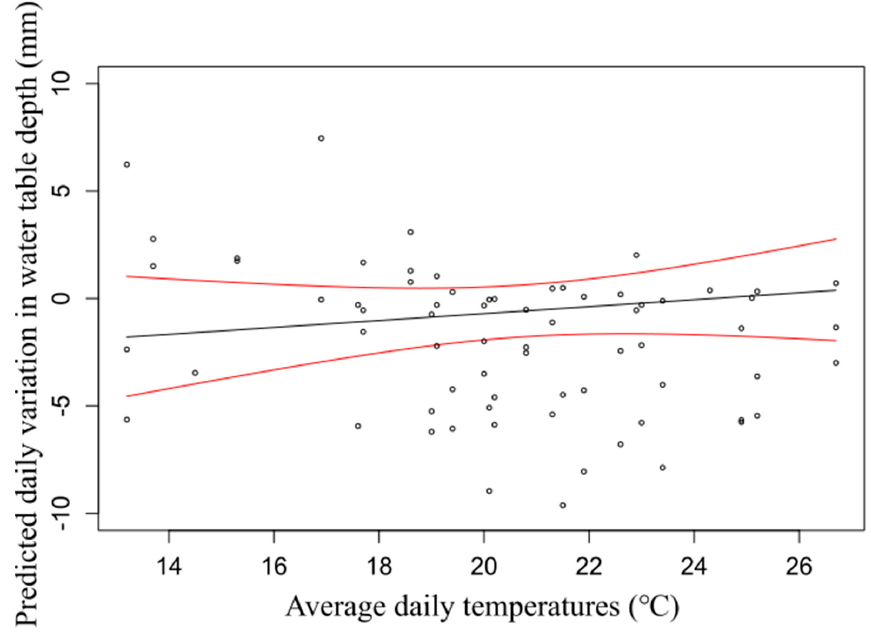
Figure 4. Predicted daily variation in water table depth before treatments based upon average daily temperatures (°C). Model ‐ averaged predictions using the entire set of candidate models are included with 95% CI. Open circles correspond to the original observations. Note that in this figure, daily variation in water table depth was back ‐ transformed from square ‐ root values.